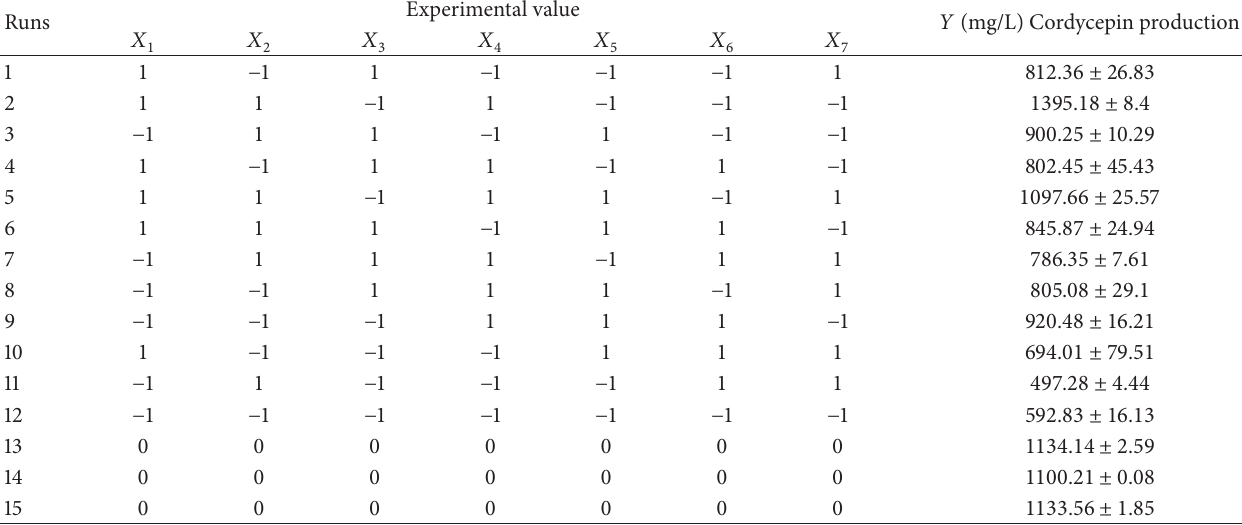
Table 2: Plackett-Burman design and response values.